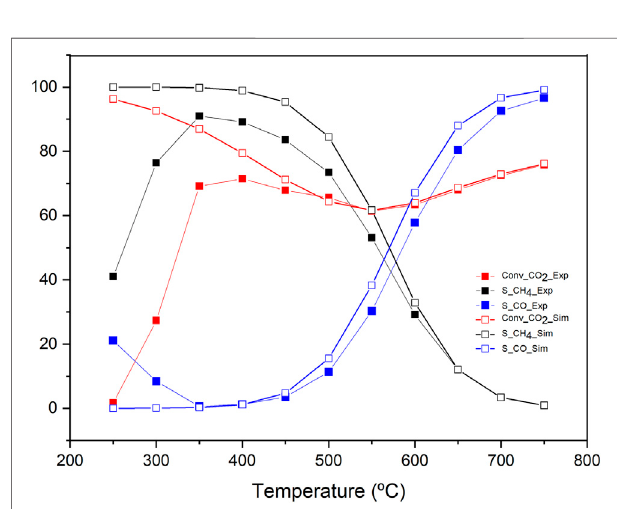
FIGURE 9 | CO selectivity of (A) non-reduced catalysts, and (B) reduced catalysts.